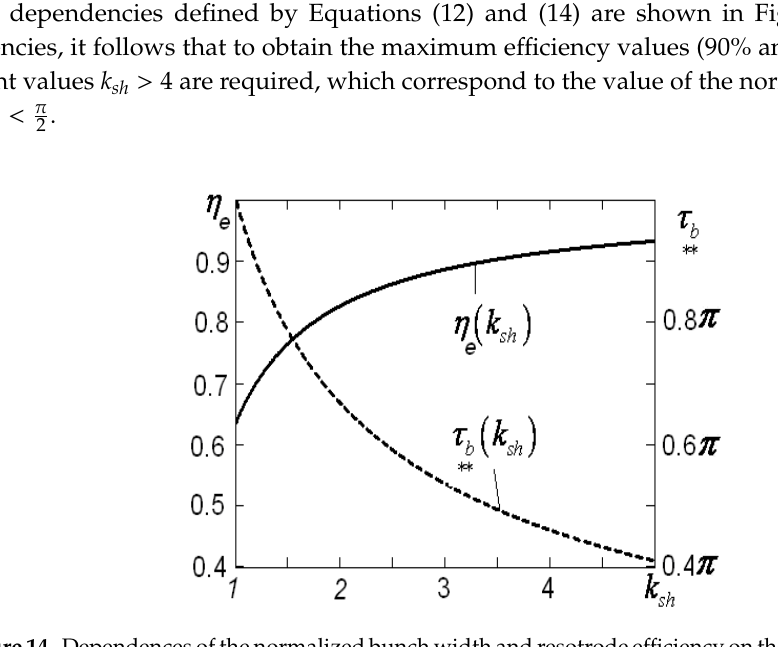
Figure 14. Dependences of the normalized bunch width and resotrode efficiency on the cutoff coefficient .